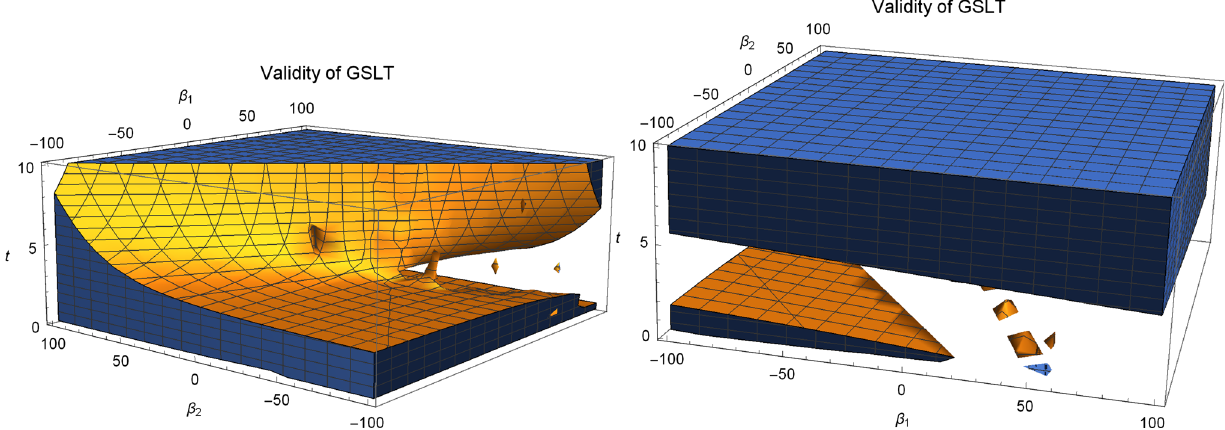
Fig. 11 Left plot represents the validity regions for logarithmic corrected entropy in intermediate case with β 3 = 0, right graph corresponds to evolution of GSLT for β 3 = − 2